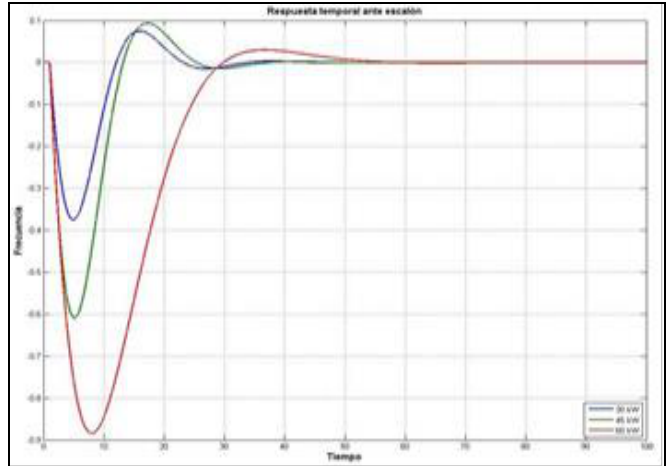
Figura 3: Respuesta lazo de control por caudal con controlador Fuzzy ante perturbación tipo escalón . Fuente: Los Autores, (2018).